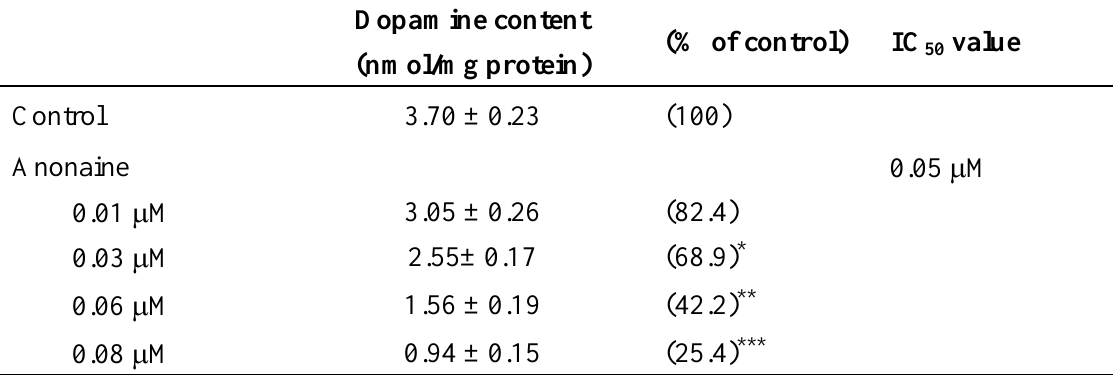
Table 1 . Inhibitory effects of anonaine on dopamine content in PC12 cells. PC12 cells were treated with anonaine for 24 h. The cells were harvested with phosphate buffered saline and dopamine content was measured by an HPLC method. The control value of dopamine content was 3.70 ± 0.23 nmol/mg protein. Results represent means ± S.E.M of 6-8 dishes.